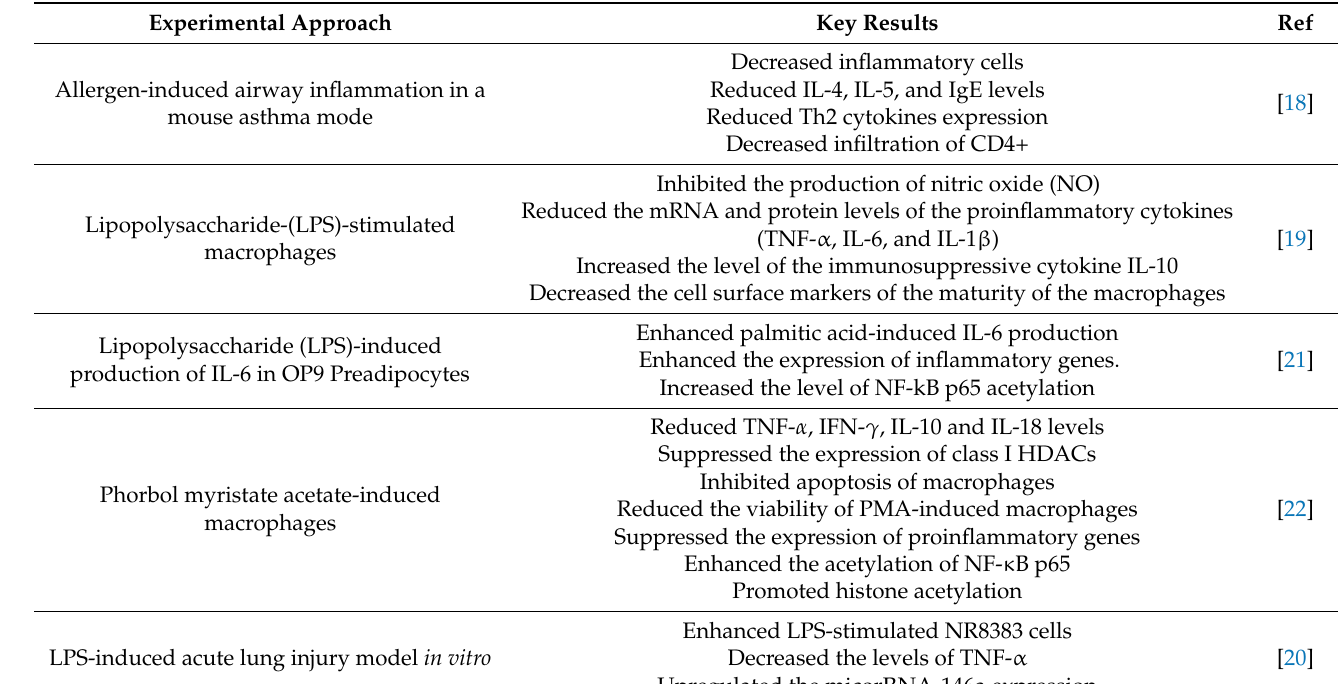
Table 3. Anti-inflammatory effects of Trichostatin A.